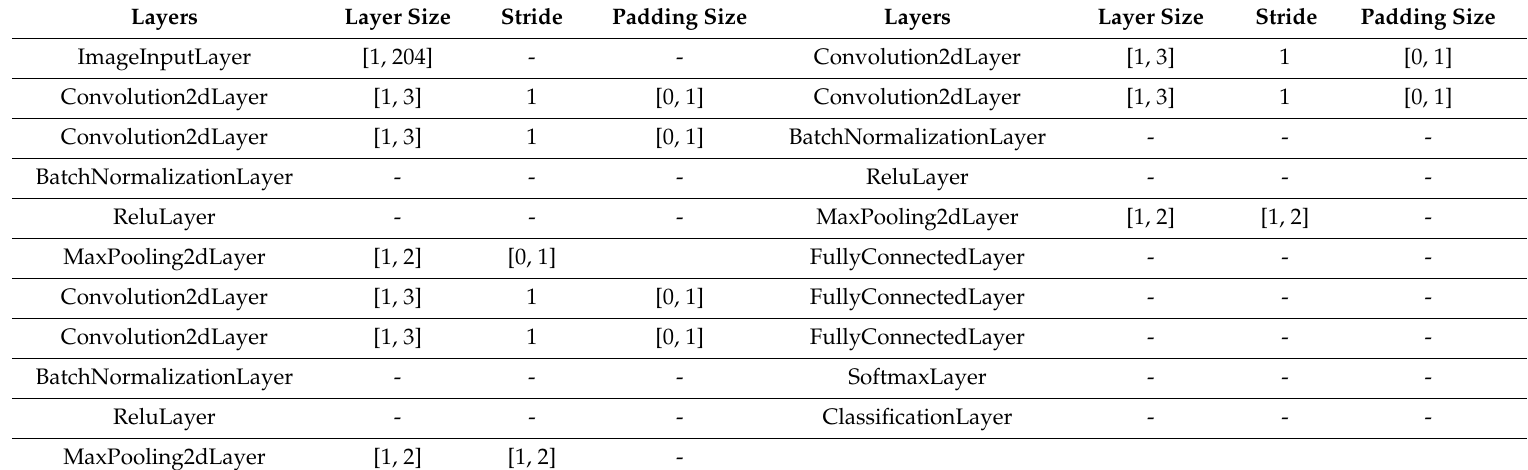
Table 1. Layers of CNN use for hyperspectral data